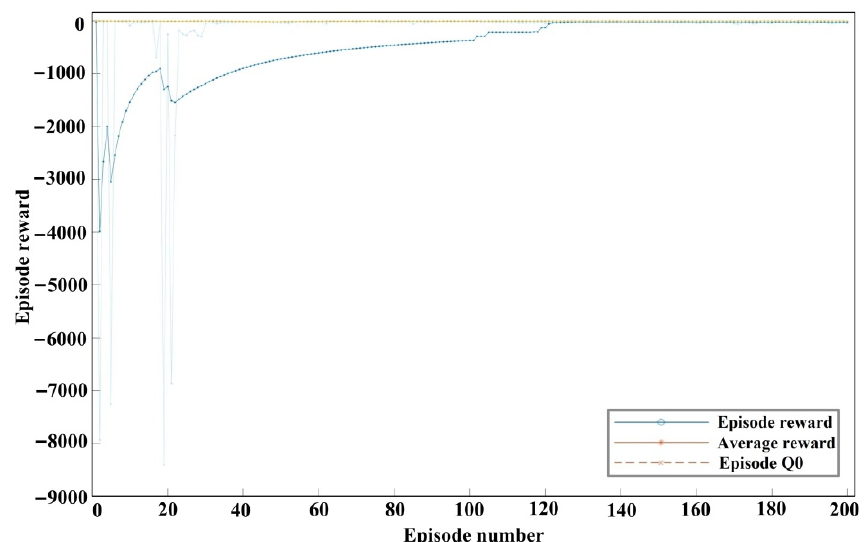
Figure 26. The training stage of the RL-TD3 agent for the correction of the u dref , u qref and i dref com- mands.